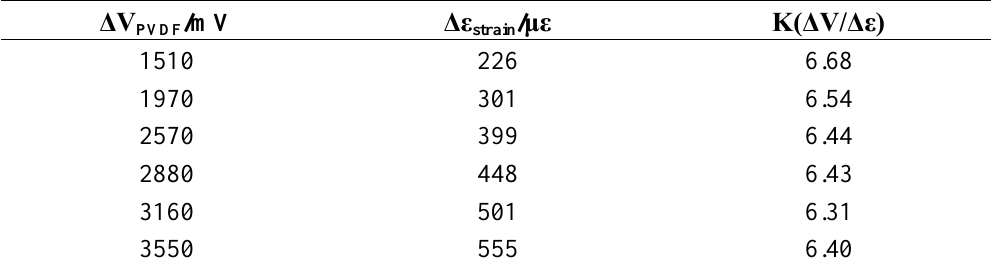
Table 6. The output of PVDF and strain gauge (5 Hz).